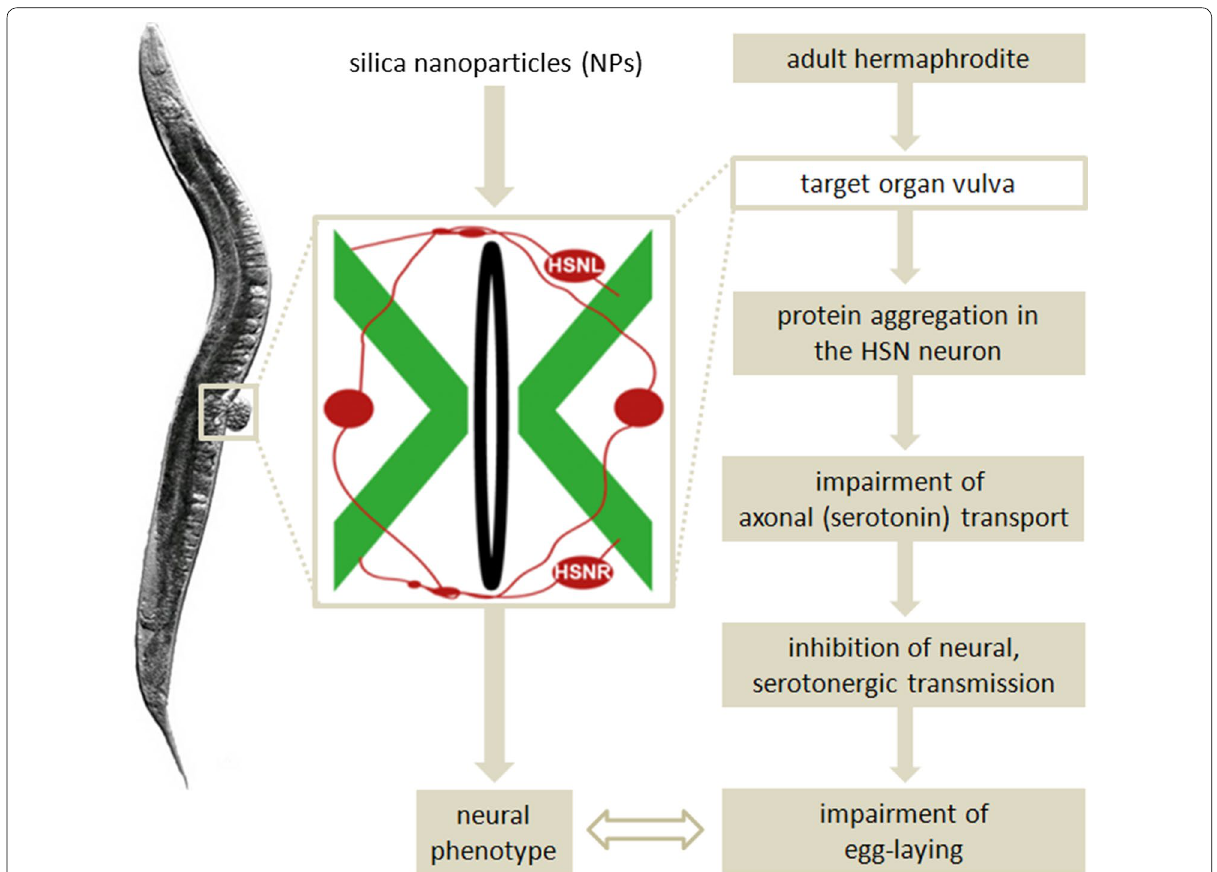
Fig. 2 Schematic depicting a cascade of neurotoxic events that underlie the impairment of reproduction by nanomaterials in the adult hermaphrodite nematode C. elegans . HSN, hermaphrodite specific neuron [11,